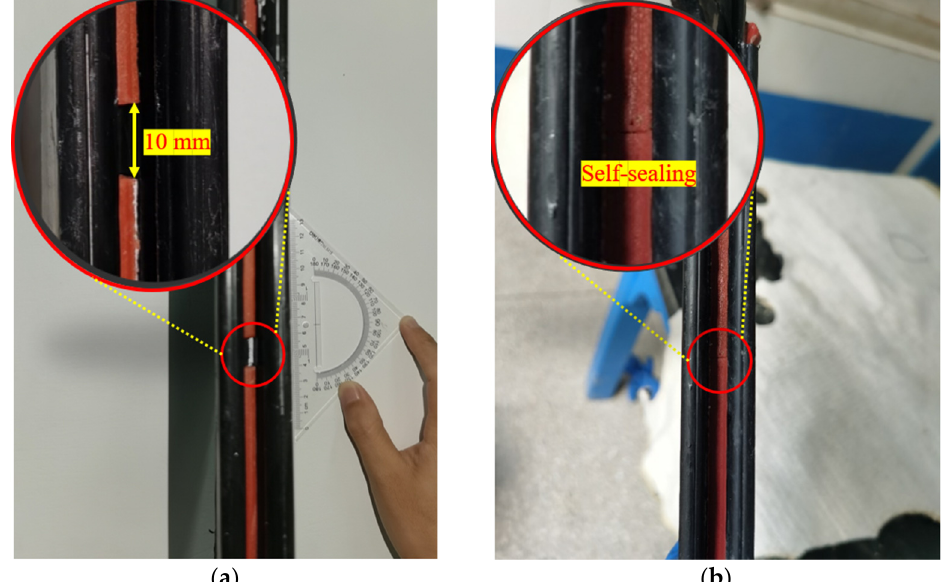
Figure 4. The pictures of: ( a ) installation of poor-sealing hydrophilic gaskets before testing, and ( b ) the self-healing behavior of the specimen after the DIW penetration.